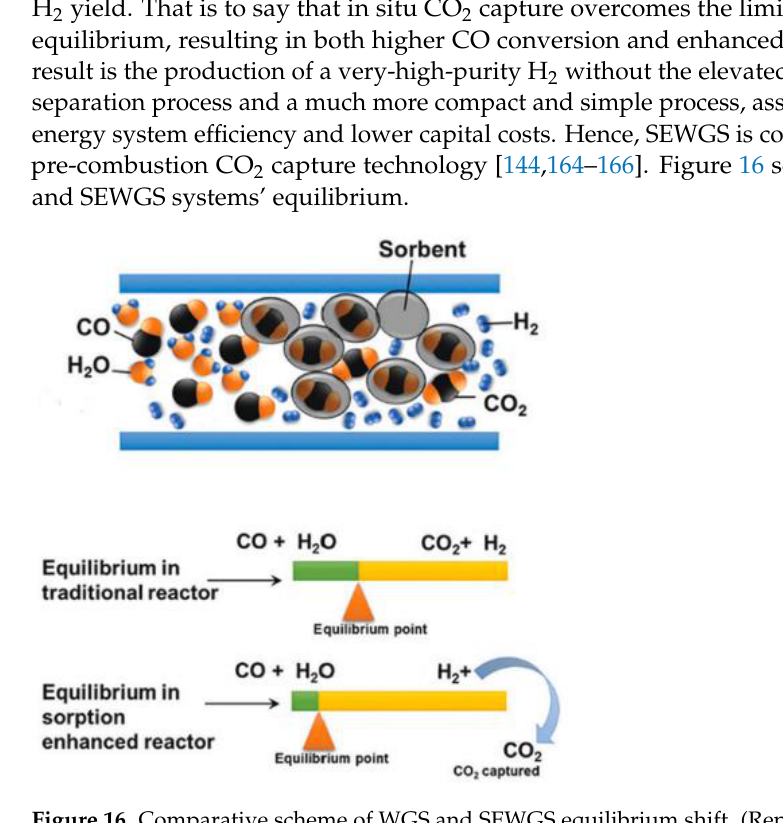
Figure 16. Comparative scheme of WGS and SEWGS equilibrium shift. (Reprinted with permission from [167]. 2019, Gao et al.).